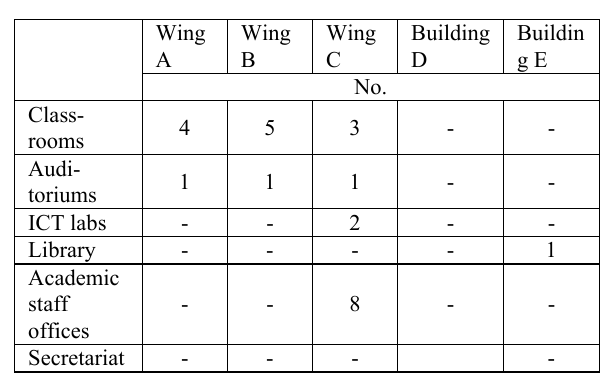
Table 1. The spaces of School of Spatial Planning and Development (Eng.)